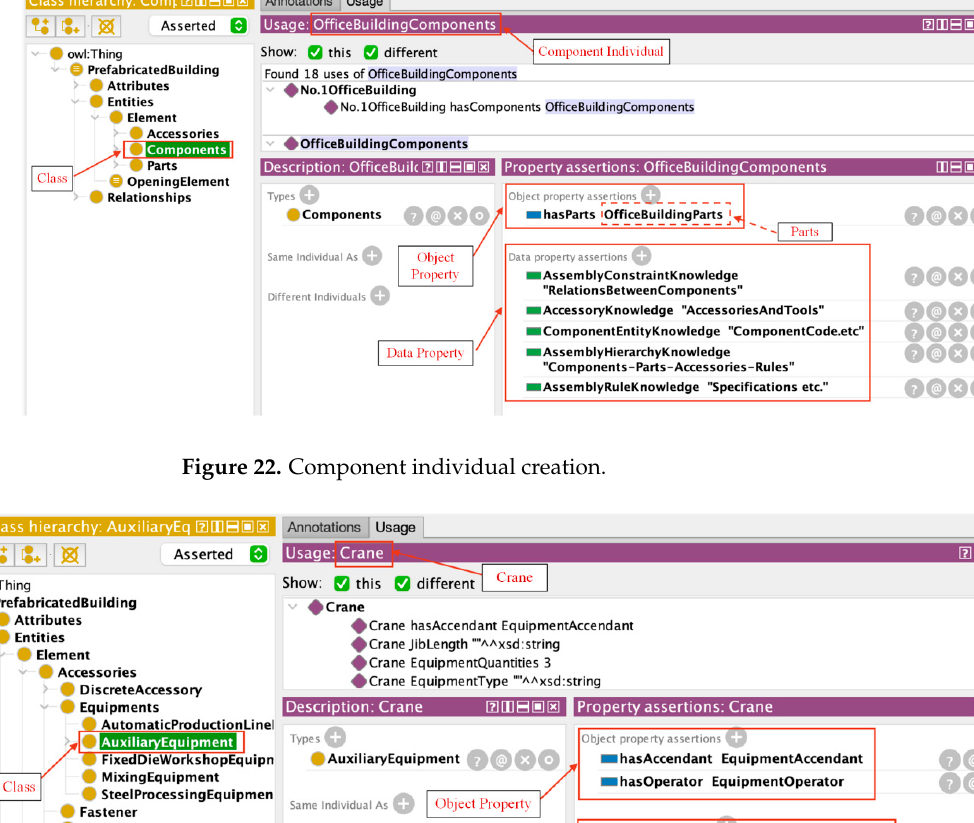
Figure 21. Project individual creation.